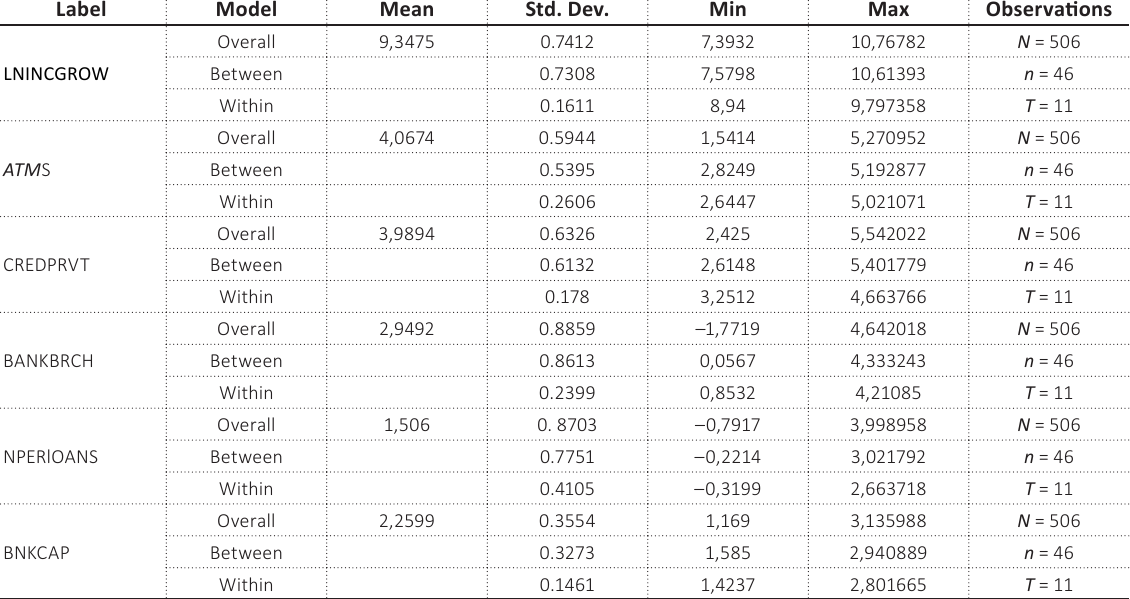
Table 2. Descriptive statistics